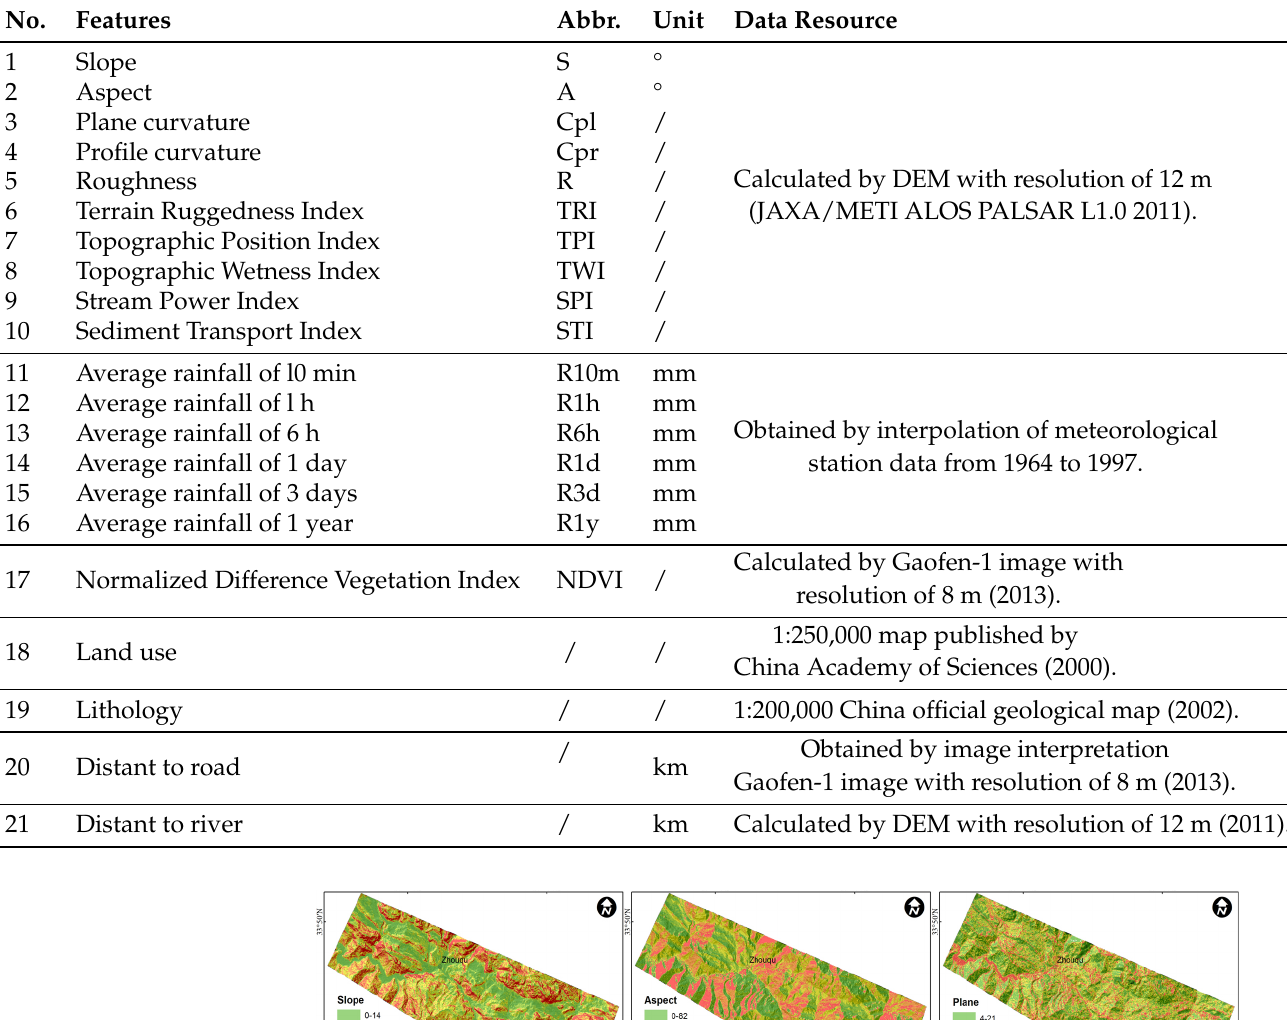
Table 1. Feature Factors Description and Data Resources.